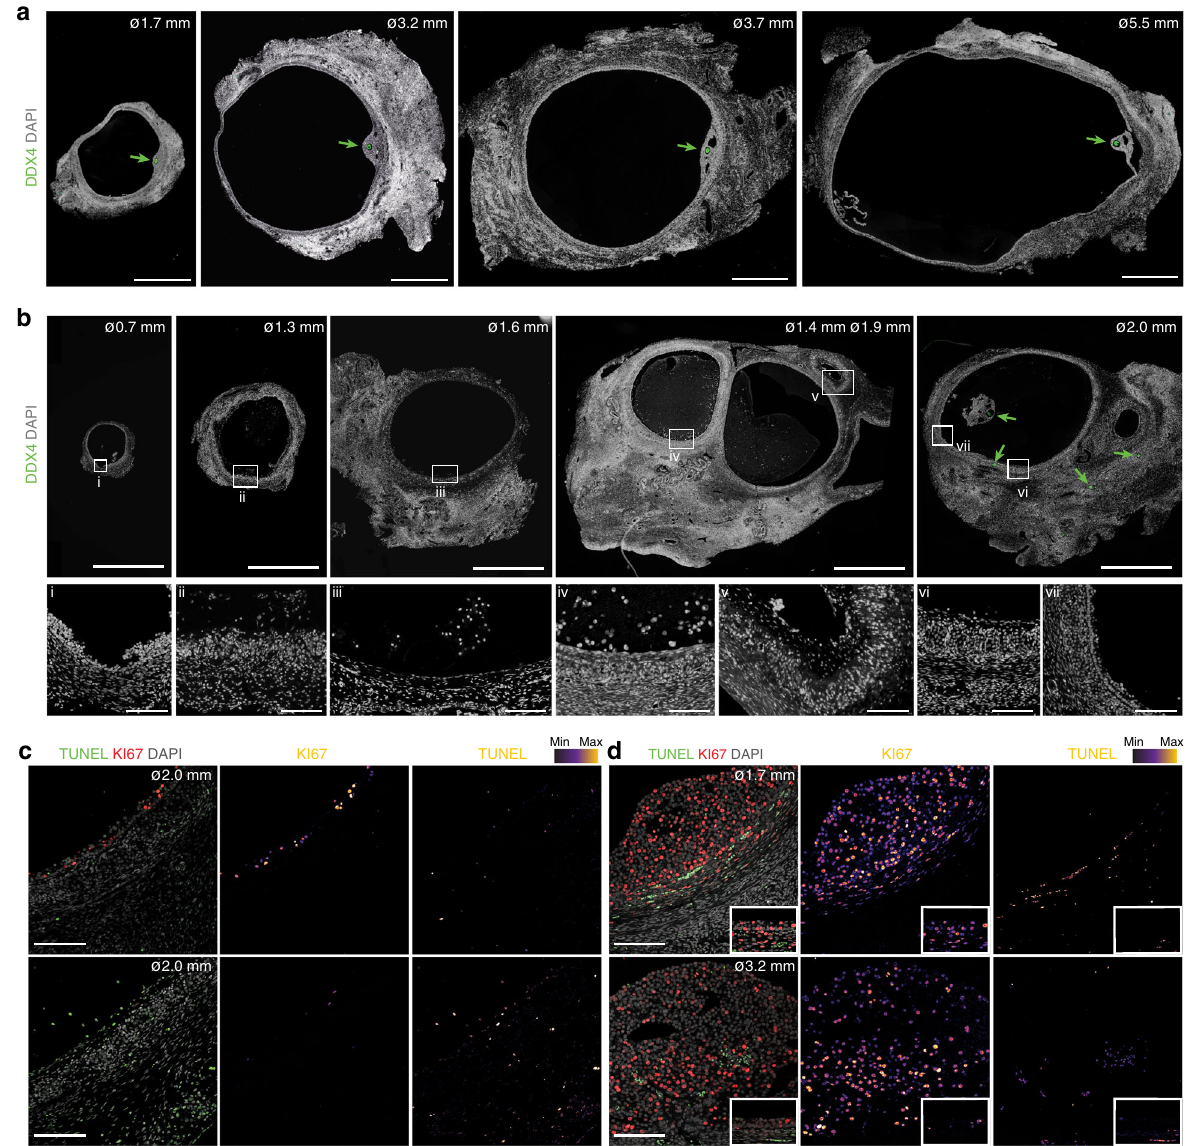
Fig. 1 Morphology of different follicles in adult ovaries. a , b Immuno fl uorescence of several healthy ( a ) and atretic follicles ( b ) of different sizes present in the ovaries immunostained for DDX4. Green arrows point to (DDX4-positive) oocytes. Panels in the bottom row show magni fi cations of the boxed areas with corresponding roman numbers. Tissue was counterstained with DAPI. Scale bars are 1 mm in two top rows and 100 μ m in bottom row (panels i-vii). c , d Immuno fl uorescence of atretic ( c ) and healthy follicles ( d ) of different sizes present in the ovaries analyzed for KI67 and TUNEL. Insets in d show a different area of the follicle showing mural GC with same magni fi cation. Single channel images were converted to an intensity map. Scale bars are 100 μ